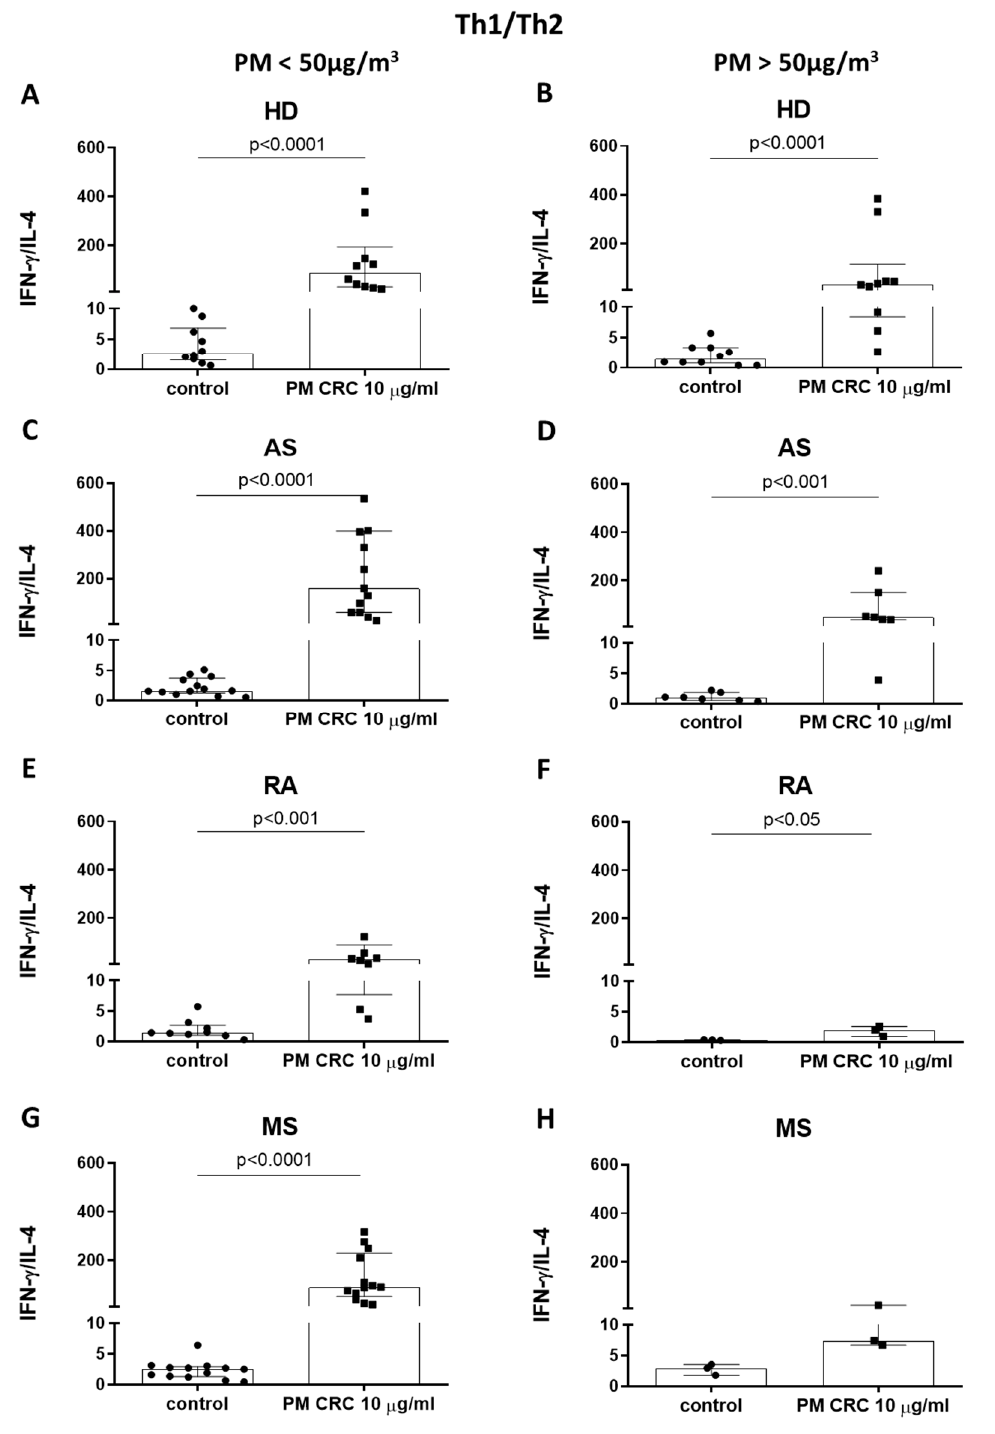
Figure 3. Effect of the exposure of PBMCs to PM CRC on the ratio of Th1/Th2 cells in patients and HD in relation to the seasonal changes in the concentration of PM in the air. After PBMCs stimulation, the proportion of CD4 + T cells positive for IFN- γ (Th1) and IL-4 (Th2), and the corresponding Th1/Th2 ratio were determined in HD ( A , B ) and patients with AS ( C , D ), RA ( E , F ), and MS ( G , H ). Results are presented concerning seasonal changes in PM10 concentration in the air, lower ( A , C , E , G ) or higher than the daily limit (50 µ g/m 3 ) ( B , D , F , H ). Data are presented as median ± interquartile range from 10 independent experiments for HD ( A , B ), 13 ( C ) and 7 ( D ) for AS, 8 ( E ) and 3 ( F ) for RA, 13 ( G ) and 3 ( H ) for MS. Statistically significant difference was estimated at p < 0.05.